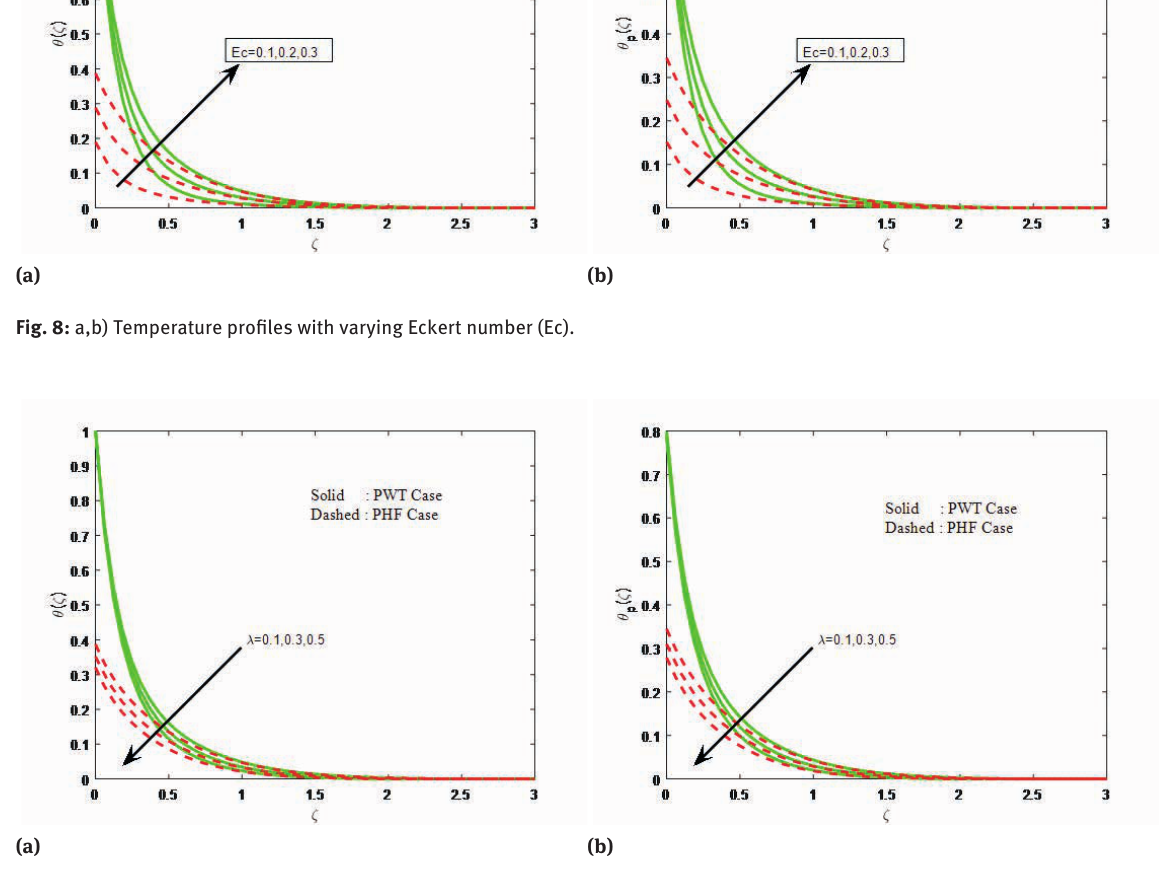
Fig. 9: a,b) Temperature profiles with varying parameter ( λ